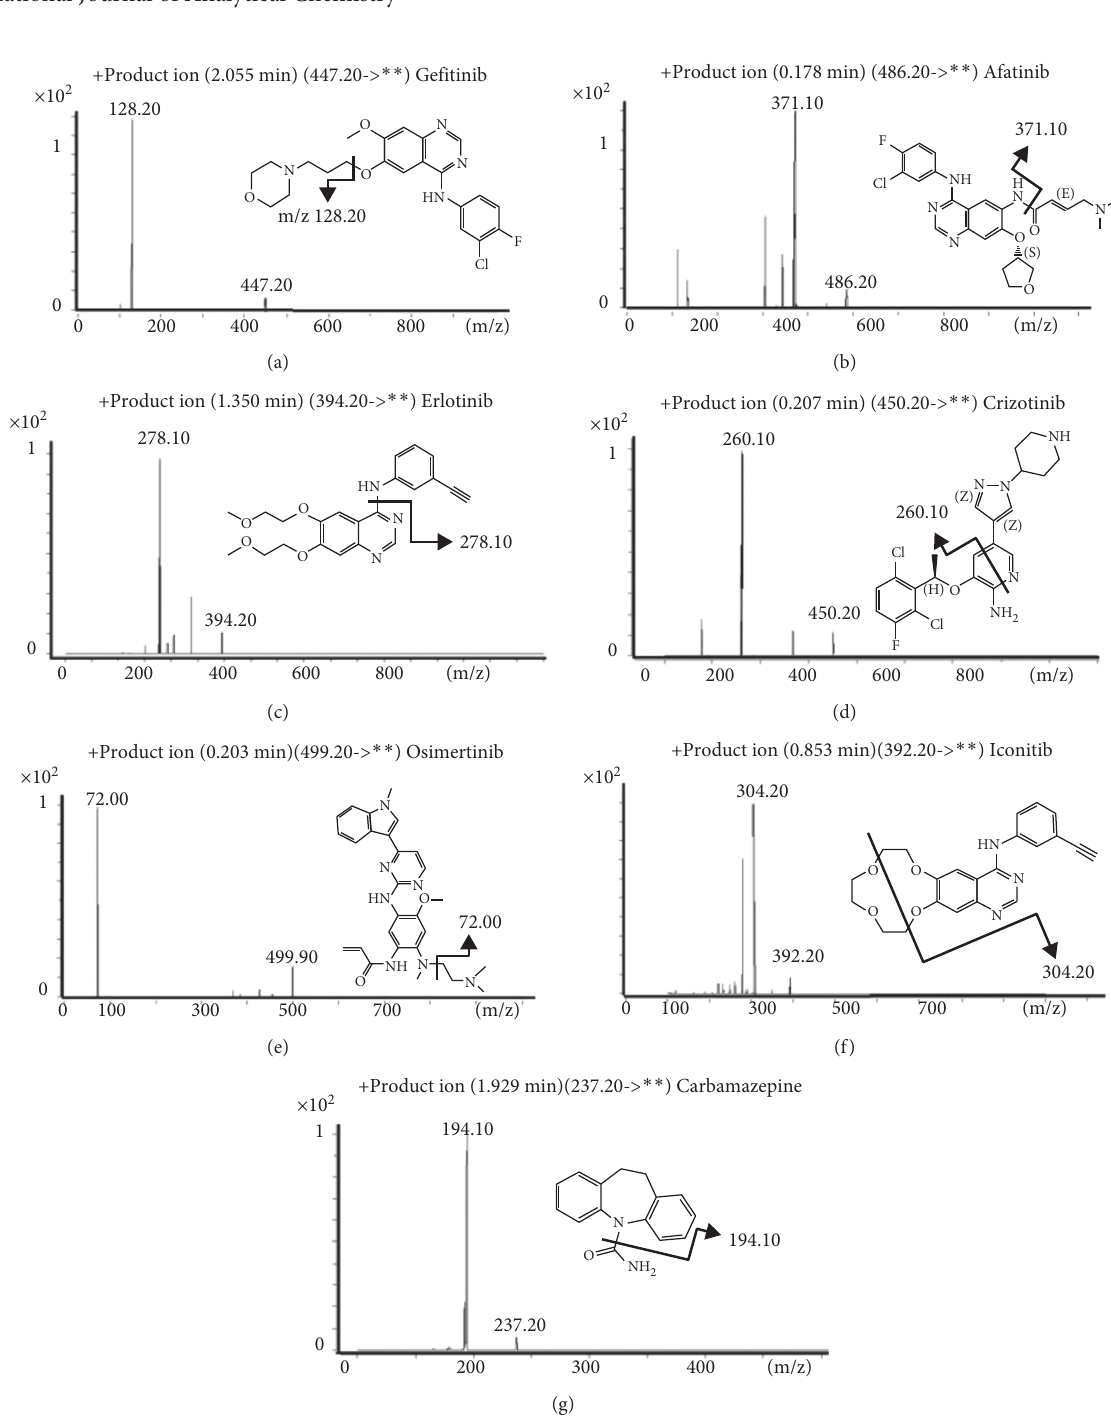
Figure 1: Product ion chromatograms and fragment structures of six TKIs. (a) Gefitinib. (b) Afatinib. (c) Erlotinib. (d) Crizotinib. (e) Osimertinib. (f) Icotinib. (g) Carbamazepine